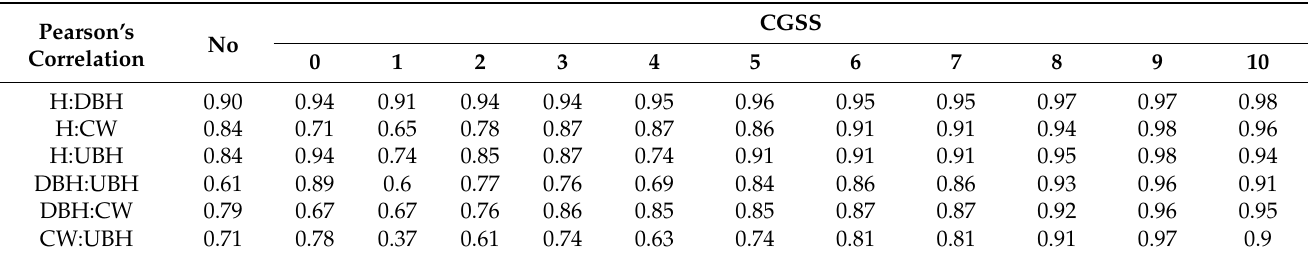
Table 5. Correlation coefficient analysis of Chinese fir morphological structure